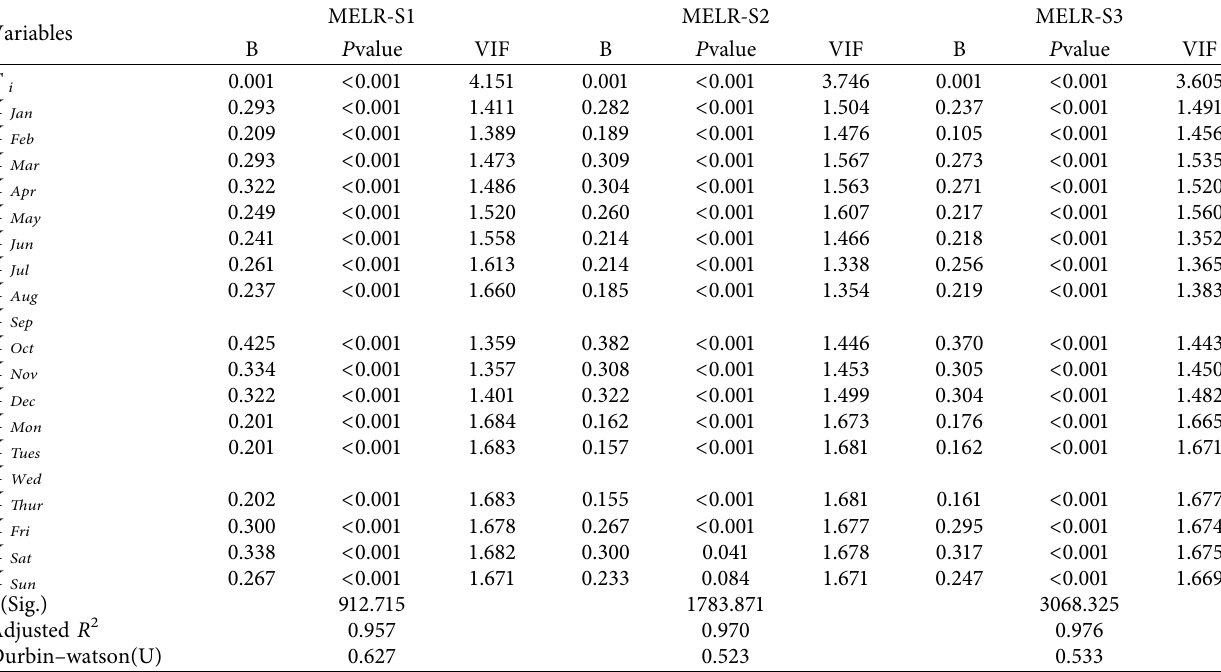
Table 2: Results of the MELR models in S1, S2, and